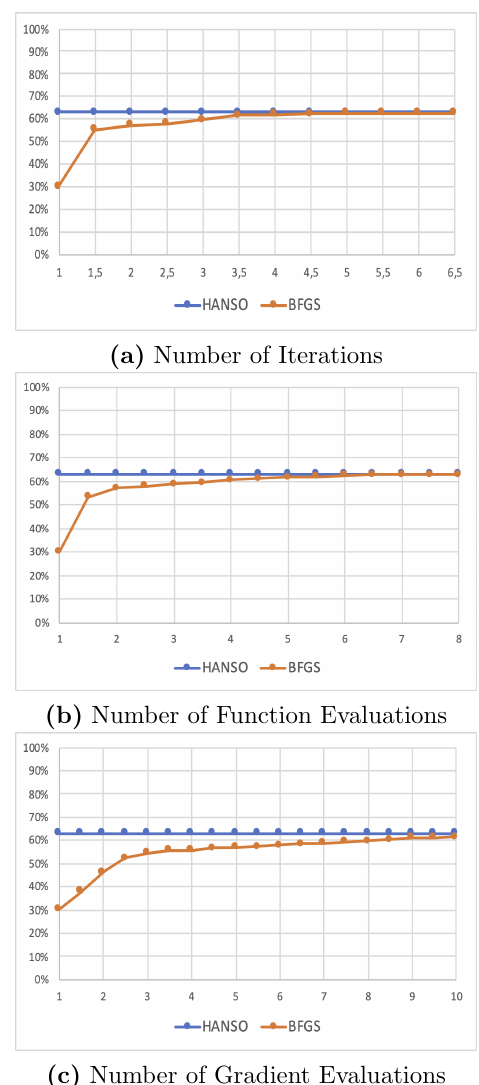
Figure 1. Performance Profiles for Convex